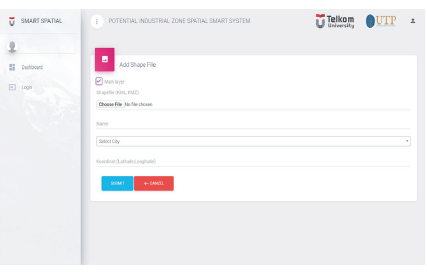
Figure 9: Input process.